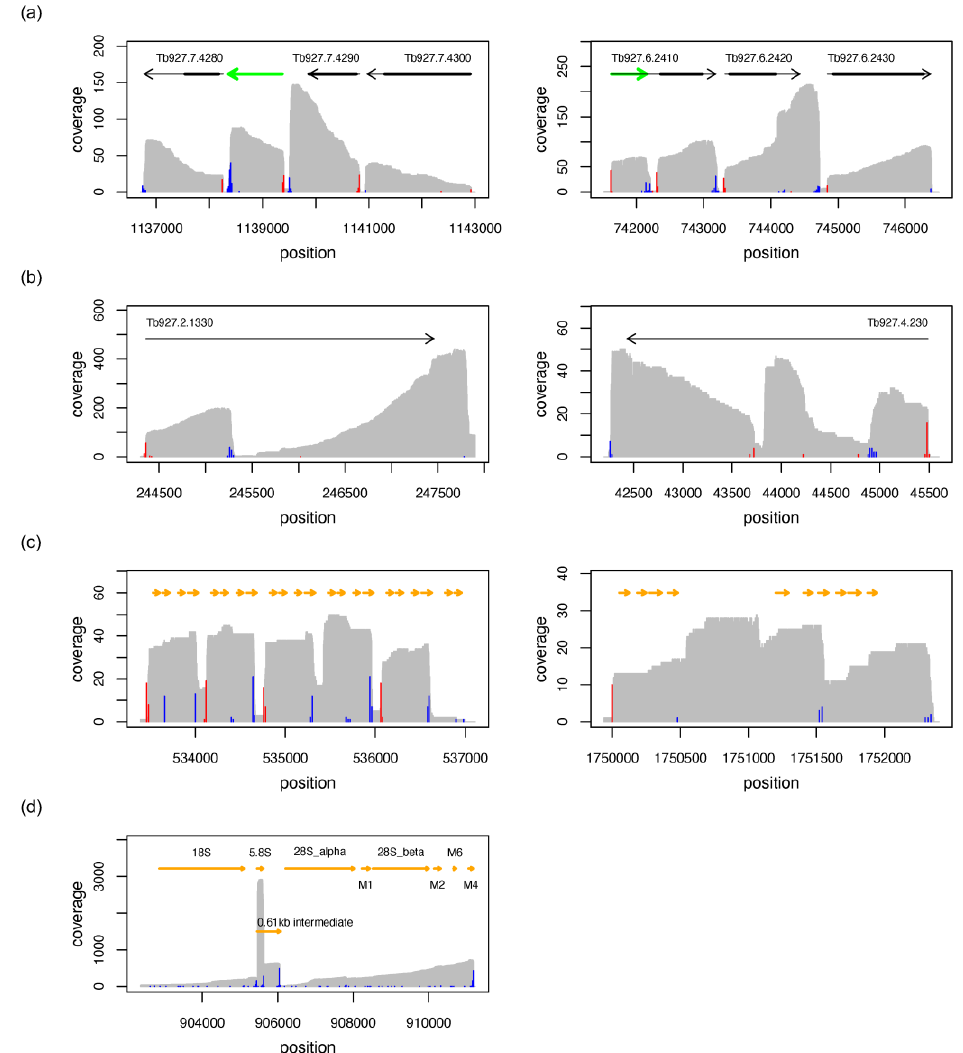
Figure 1. Coverage plots (grey) of representative nanopore-based direct RNA sequencing results. ( a ) Precise mapping of annotated transcript boundaries, correction of annotated UTRs, and detection of novel-intergenic (left) or UTR-based transcripts (right). Grey arrows are annotated genes and thick black lines denote coding sequences. Green arrows are novel transcripts. Splice acceptor sites are in red, and polyadenylation sites are in blue. ( b ) Mapping of pseudogene-derived transcripts. ( c ) Mapping of snoRNA precursors (arrows in yellow). ( d ) Detection of rRNA maturation intermediates (arrows in orange). The data in ( a , b ) are derived from bloodstream-stage trypanosomes. The data in ( c , d ) are from procyclic-stage parasites. The following genomic regions are presented: ( a )